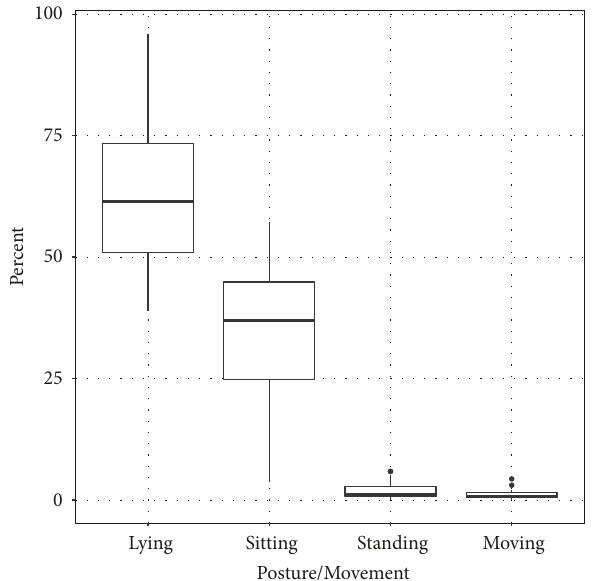
Figure 4: Summary of posture and movementduring measurement